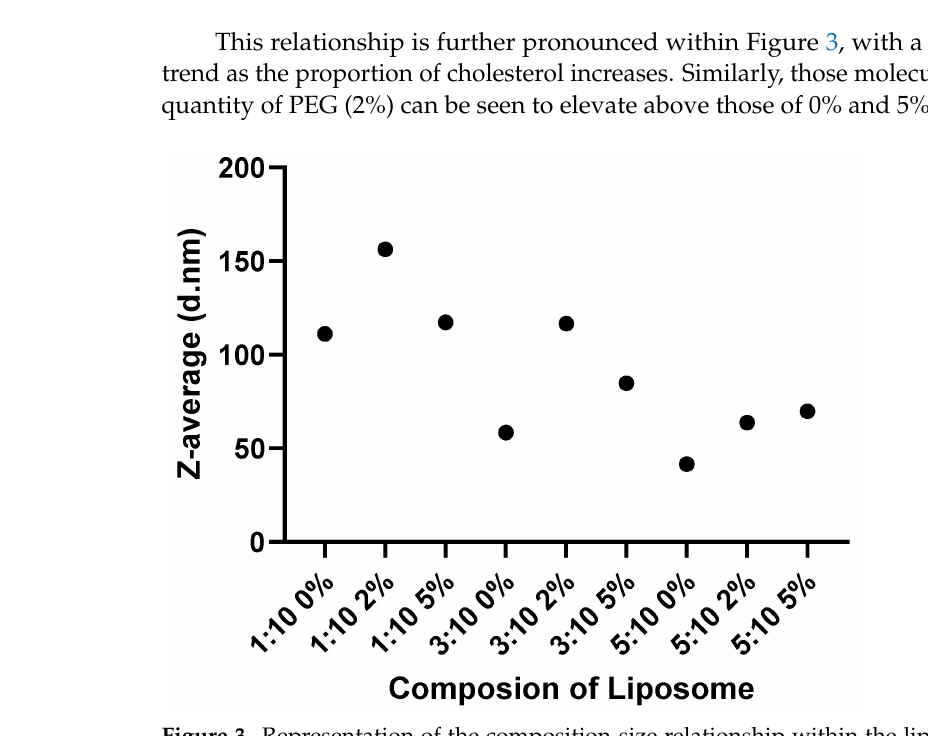
Figure 3. Representation of the composition-size relationship within the liposomes used. Values expressed as a mean ( n =